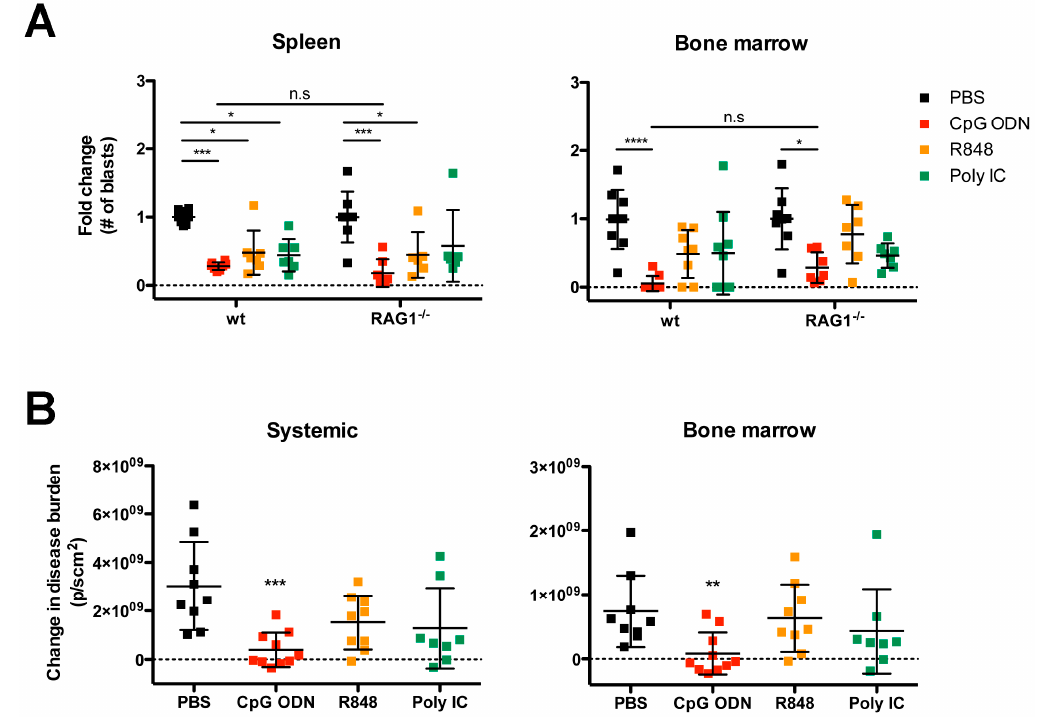
Figure 2. Endosomal TLR-induced immune activity is sufficient to initiate in vivo depletion of primary B-ALL. ( A ) Wild-type (wt) and RAG − / − BALB/c mice bearing primary E μ -ret B-ALL cells received a single 100 μ g dose of indicated TLR agonists. Results shown are pooled from four independent experiments: PBS-treated wt (n = 8) and RAG − / − BALB/c (n = 8); CpG ODN-treated wt (n = 8) and RAG − / − BALB/c (n = 7); R848-treated wt (n = 7) and RAG − / − BALB/c (n = 6); polyI:C-treated wt (n = 7) and RAG − / − BALB/c (n = 6). ( B ) NOD/SCID mice bearing human primary ALL expressing firefly luciferase were treated with the indicated TLR agonists and disease burden measured systemically and in bone marrow by in vivo bioluminescence imaging. Results shown are pooled from four independent experiments. PBS-treated NOD/SCID (n = 9); CpG ODN-treated NOD/SCID (n = 10); R848-treated NOD/SCID (n = 9); polyI:C-treated NOD/SCID (n = 8). ( A ) Tukey’s multiple comparisons test, bars represent mean ± S.D.; * p < 0.05, *** p < 0.001, **** p < 0.0001, n.s = not significant. ( B ) Dunn’s multiple comparisons test, bars represent mean ± S.D.; ** p < 0.01, *** p < 0.001.